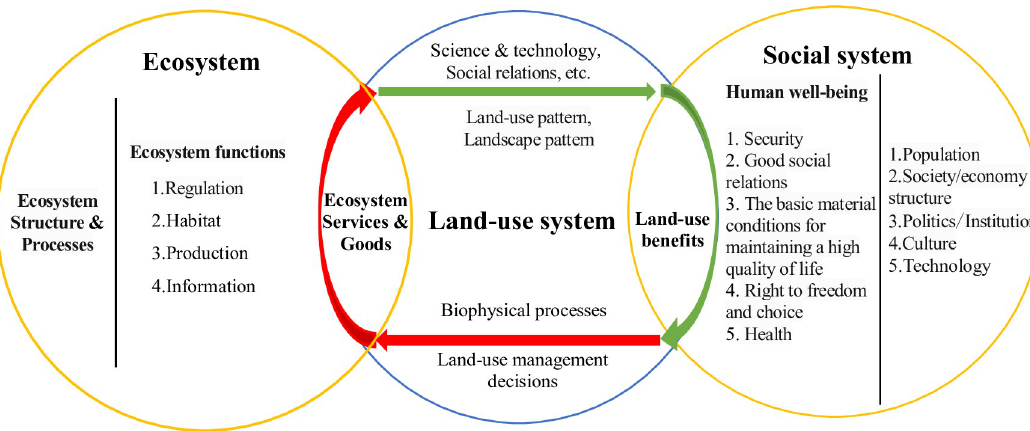
Fig 1. Analysis framework of the basic connotations of land-use